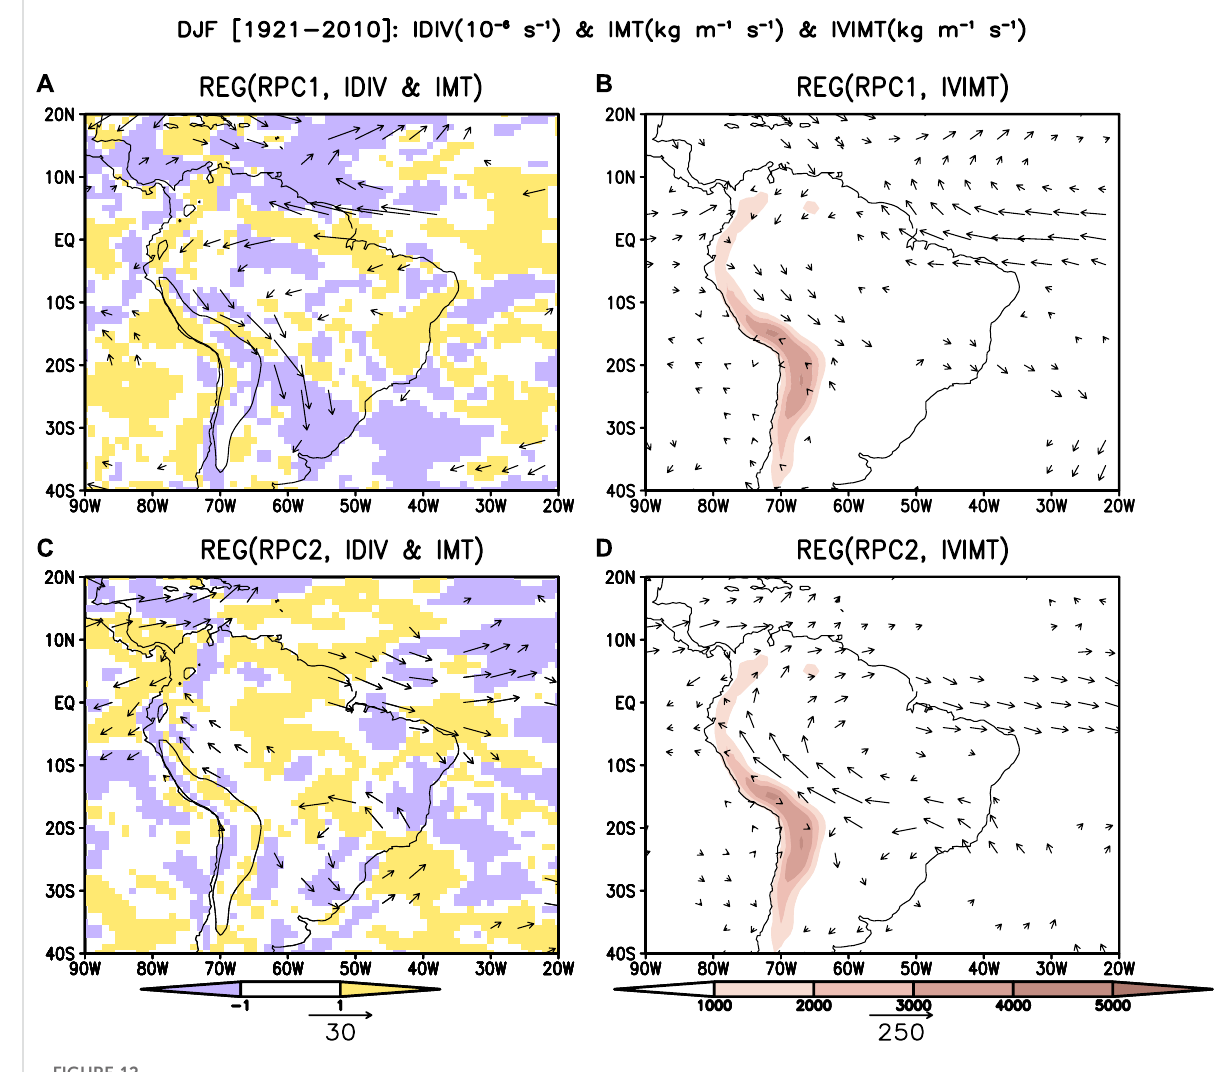
FIGURE 12 Linear regression coef fi cients between the interdecadal component of the DJF moisture transport and divergence anomalies over South Americaat850 hPaand (A) the fi rstrotatedprincipalcomponentoftheinterdecadalvariabilityoftheDJFprecipitationovertheCentralAndes(RPC1). (C) As in (A) but for the second rotated principal component of the interdecadal variability of the DJF precipitation over the Central Andes (RPC2). (B,D) As in (A,C) but for vertically integrated moisture transport anomalies. The moisture transport (kg m − 1 s − 1 per standard deviation) anomalies statistically signi fi cant at the 95% con fi dence level are shown in bold. Shading represents divergence above (below) 1 × 10 – 6 s − 1 ( − 1 × 10 – 6 s − 1 ) per standard deviation. Black vectors are statistically signi fi cant at the 95% con fi dence level. Vectors are only shown where either zonal or